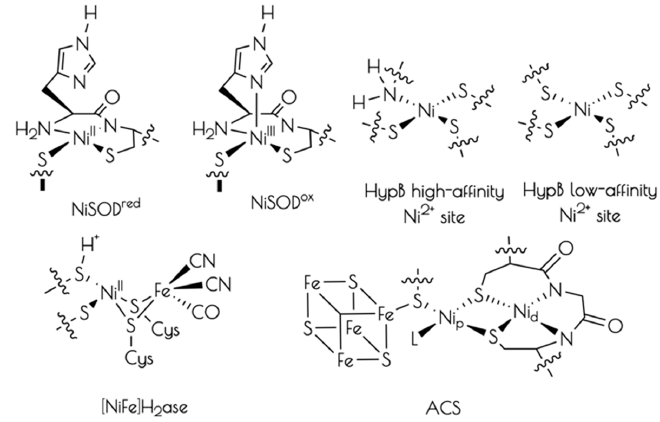
Chart 1. Representative structures of the active sites of cysteinate-ligated nickel containing